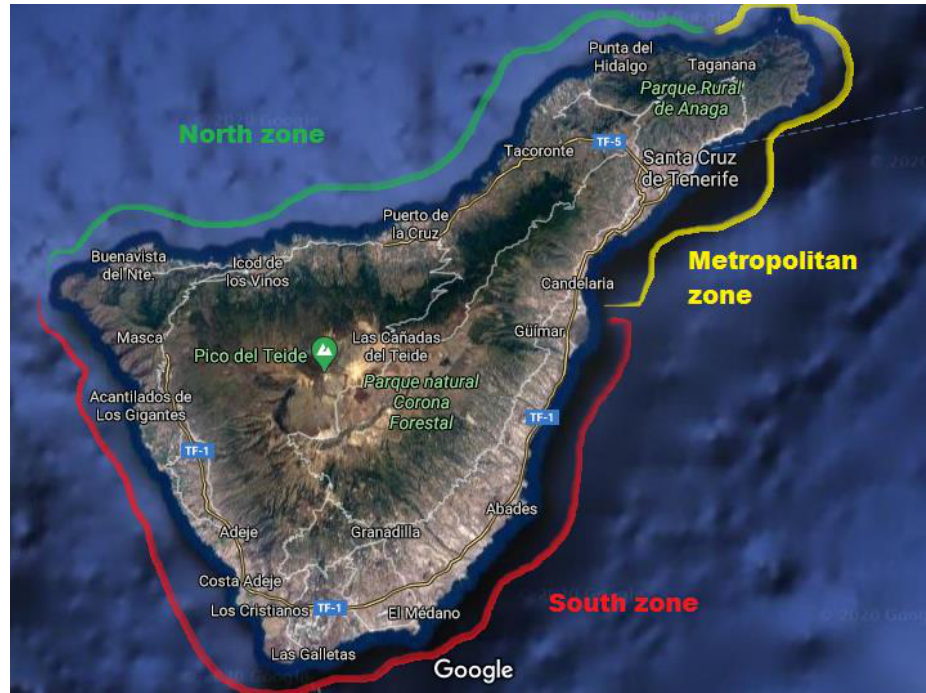
Figure 1. Sampling zones around the island of Tenerife.